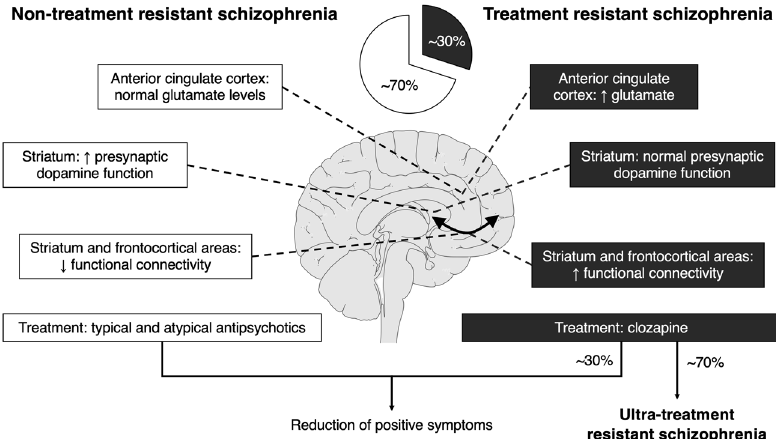
Fig. 1 Neurobiology of nontreatment-resistant and treatment-resistant schizophrenia. Approximately 30% of schizophrenia patients do not respond to fi rst-line antipsychotics; treatment response or non-response is associated with distinct neurobiological changes within the corticostriatal circuitry. Of treatment-resistant patients, approximately 70% do not respond to clozapine. No treatment provides meaningful improvements to negative or cognitive